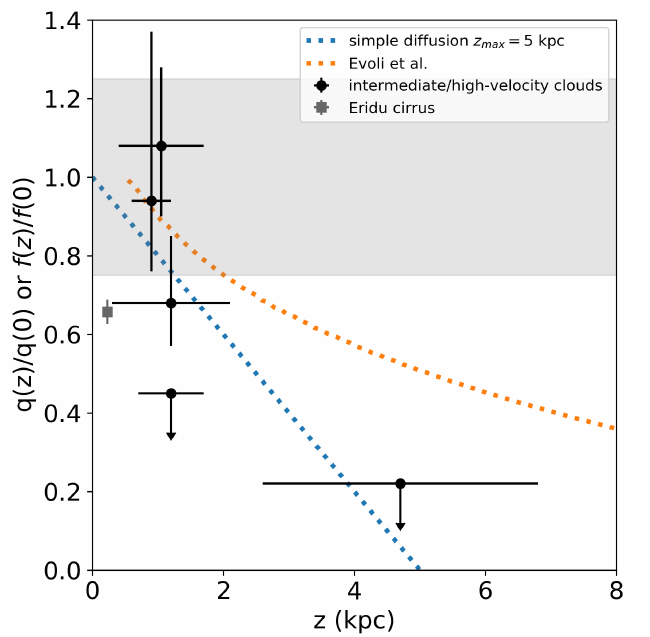
Figure 4. Vertical gradient of gamma-ray emissivities or cosmic-ray densities in the Milky Way halo. The points correspond to emissivity measurements derived from Fermi LAT data for intermediate- and high-velocity clouds with distance brackets based on stellar probes [269] and for the Eridu cirrus [203]. The horizontal band shows the 25% dispersion of emissivity measurements for nearby clouds (Section 3). The lines correspond to CR densities from two models: the z-dependent part of the solution of the diffusion equation in the plane-parallel geometry (infinitely thin Galactic plane) with a uniform source distribution when only ionization losses are assumed for the halo height z max = 5 kpc inferred from recent direct CR measurements [194,267] and the model by Evoli et al. [181], which describes CR vertical propagation based on a mixture of advected turbulence and of CR self-generated waves (we show the CR densities at 10 GeV which are most representative for the gamma-ray energies